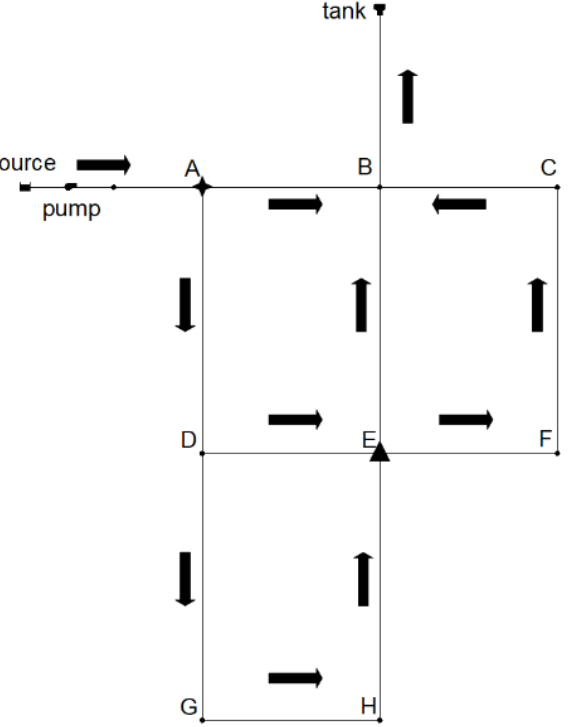
Figure 1. Configuration of the physical system of a WDN.